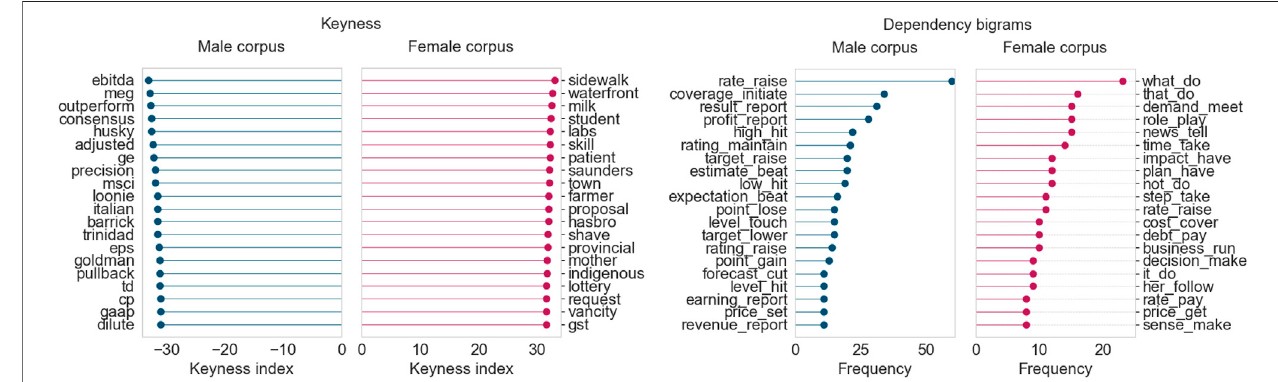
FIGURE 7 | Corpus analysis results for top 200 articles from “ Business ” (October 2018).